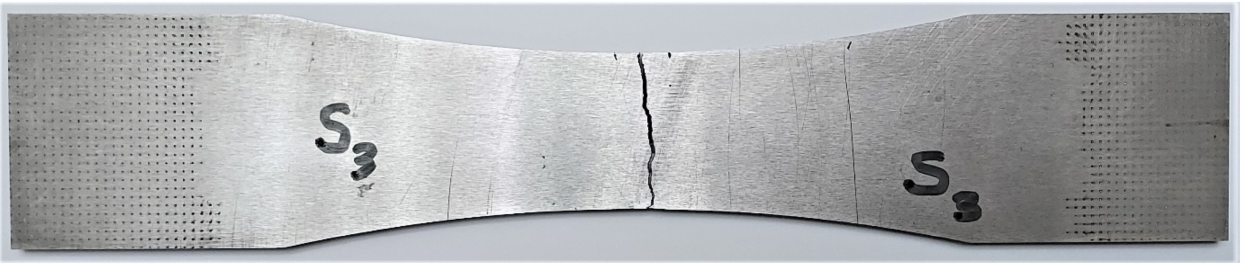
Figure 11. Plan view of the failed specimen.